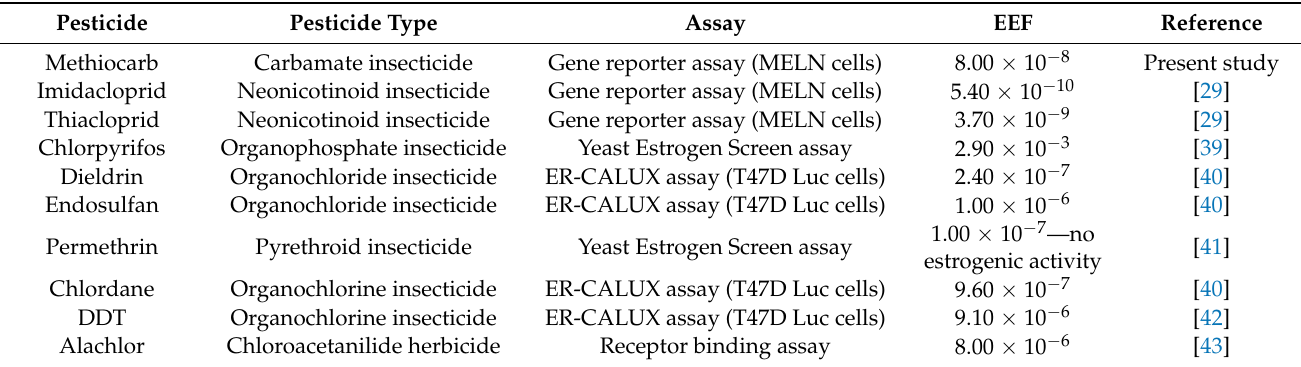
Table 2. Estrogenic potency of Methiocarb assessed in the present study using a gene reporter assay in comparison with estrogenic potency of other pesticides reported by other studies using different assays. Estrogenic potency is expressed as 17 β -estradiol equivalency factor (EEF). EEF of 17 β -estradiol =